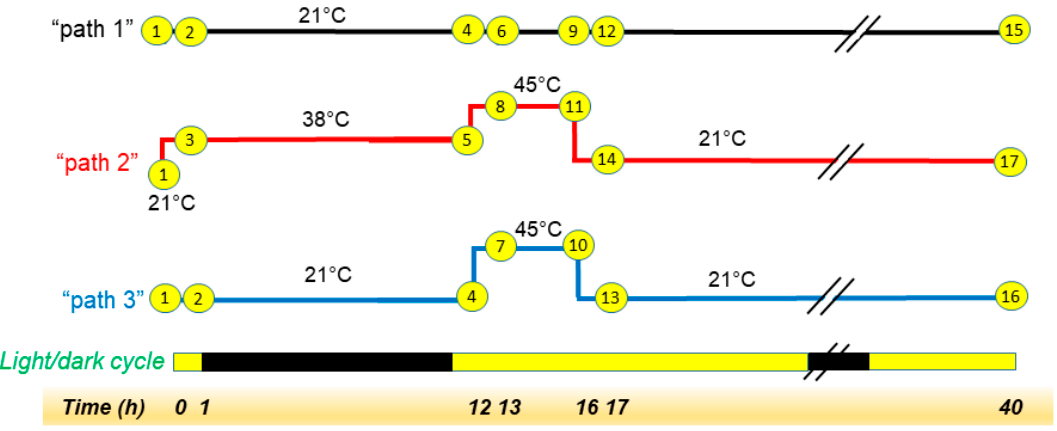
Figure 1. Heating experiment design. Plants 28-days-old were grown on a 14-h light, 10-h dark cycle at 21 ◦ C. The experiment began 13 h into the light phase of the cycle (1 h before the start of the dark phase), and the original light cycle continued through the experiment. Plants were subjected to one of three treatments: “Path 1” (control): 21 ◦ C for 40 h; “Path 2”: 38 ◦ C for 12 h, 45 ◦ C for 4 h, and 21 ◦ C for 24 h; or “Path 3”: 21 ◦ C for 12 h, 45 ◦ C for 4 h, and 21 ◦ C for 24 h. Sampling points were at 0 h, 1 h, 12 h, 13 h, 16 h (end of heat phase for paths 2 and 3), 17 h, and 40 h. At these times, leaves 5 and 6 were removed, and the remainder of the rosette was harvested and extracted for lipid analysis. (Each plant produced one experimental sample.) The plant tray numbers (Table S1) corresponding to each treatment / time point are indicated in the yellow symbols.